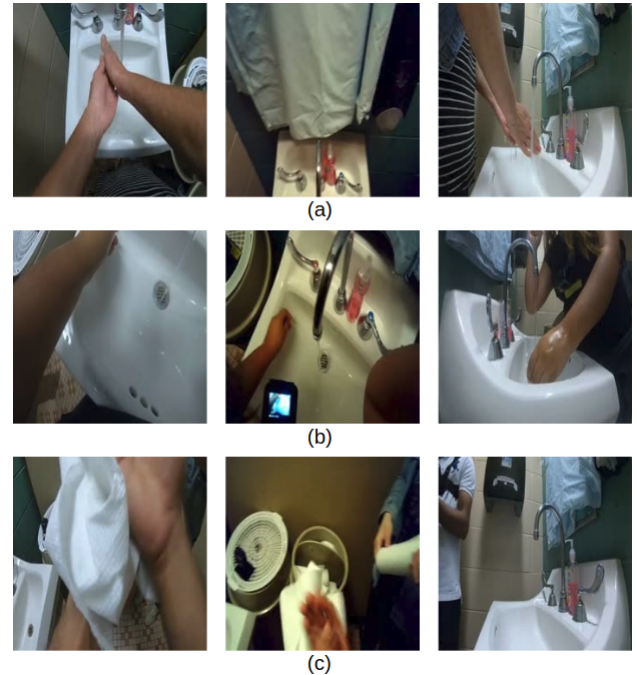
Figure 9. Images from chest camera (left), nose camera (middle), and wall camera (right): ( a ) “rub hands without water”; ( b ) “touch faucet with elbow”; ( c ) “dry